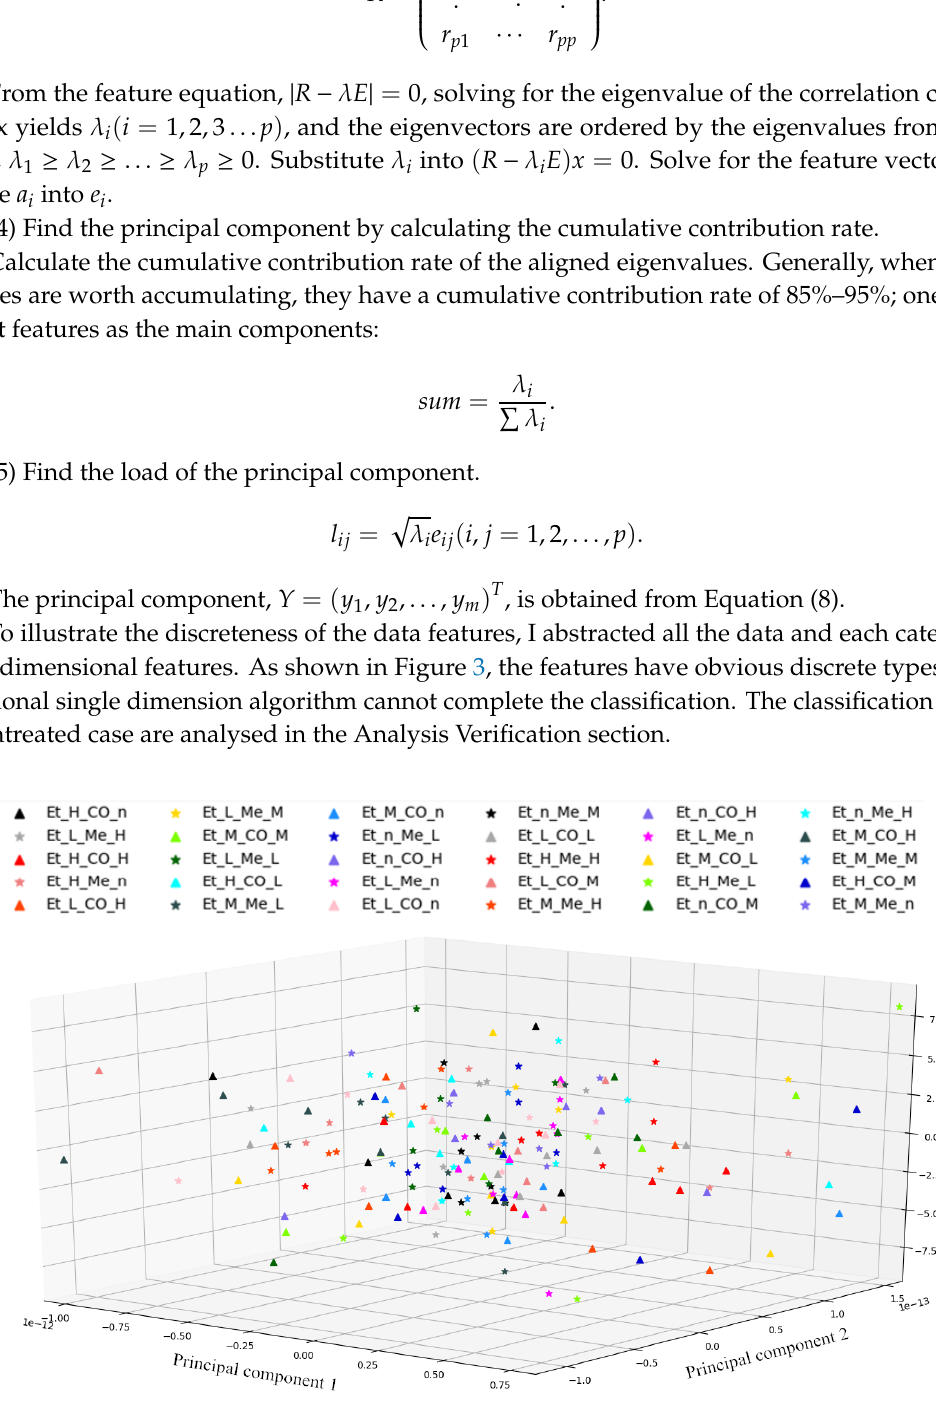
Figure 3. Feature engineering abstract 3D features.